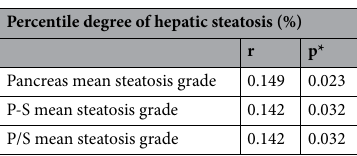
Table 4. Correlation analysis for pancreatic steatosis grade for each CT measument model. *Spearman correlation.